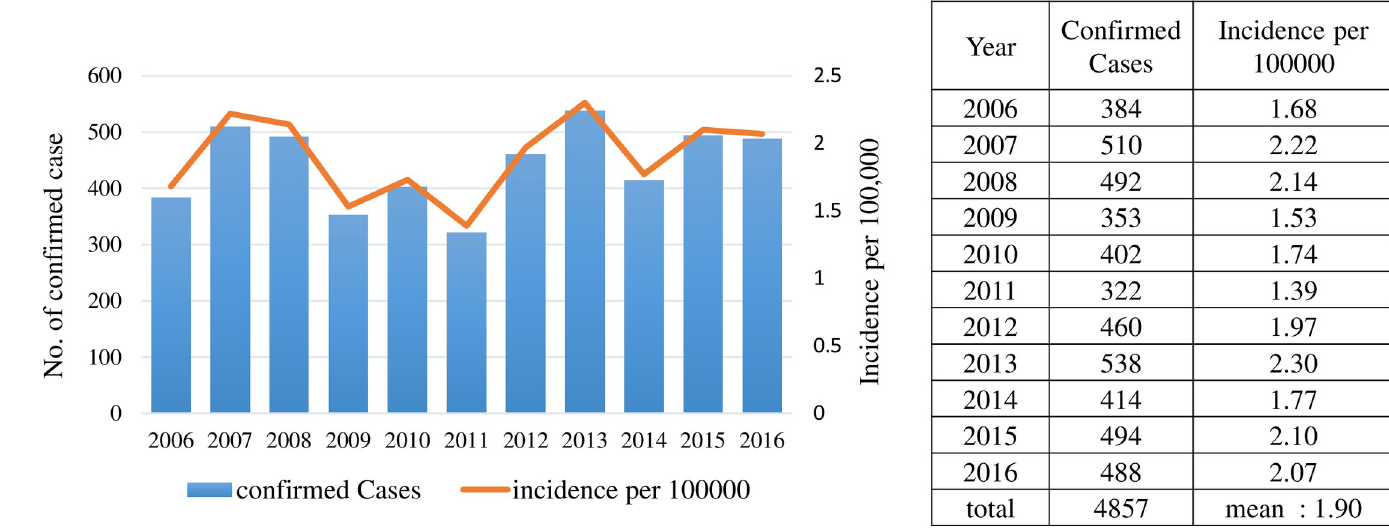
Fig 1. Annual numbers of confirmed cases of scrub typhus cases in Taiwan 2006–2016. There is an increasing trend of O. tsutsugamushi infection in Taiwan.